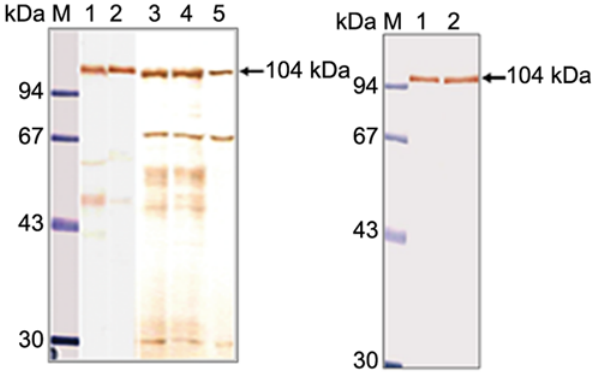
Figure 5. Immunoblotting analysis of native LKR/SDH. The partially purified LKR/SDH enzyme from midgut, ovary and egg lysates of partially fed adults, and whole body lysates of larvae, nymphs, unfed adult, and fed adult H. longicorns were used as antigens. A. Lane M, protein marker; lane 1, egg lysate; lane 2, larva lysate; lane 3, nymph lysate; lane 4, unfed tick lysate; lane 5, engorged tick lysate. B. Lane M, protein marker; lane 1, adult midgut; lane 2, adult ovary. doi:10.1371/journal.pone.0007136.g005 Alexa 594-conjugated anti-mouse immunoglobulins were used as second antibodies. As shown in Figure 6 , strong positive fluorescence was observed in the ovary oocytes and midgut digestive cells, indicating the endogenous enzymes were expressed in these cells.